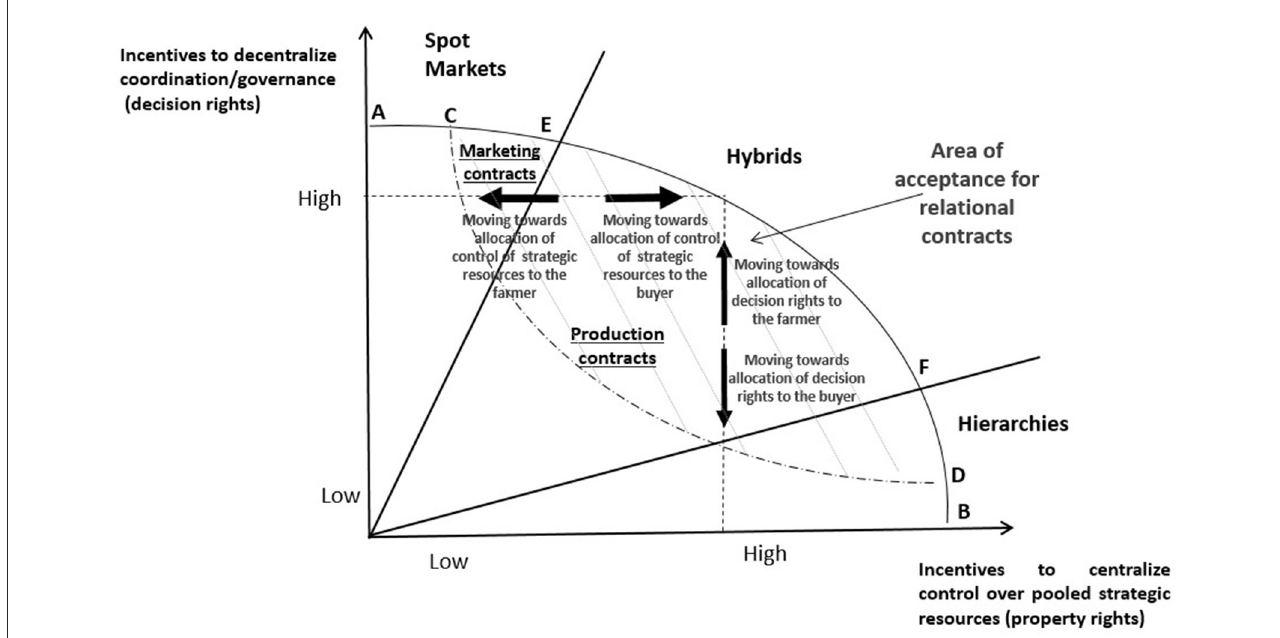
FIGURE1 Setting the research problem under the NIE lens: linking property and decision rights, transactional attributes, and organizational arrangements. Source: Our elaboration based on Ménard (2017, 2018, 2022).